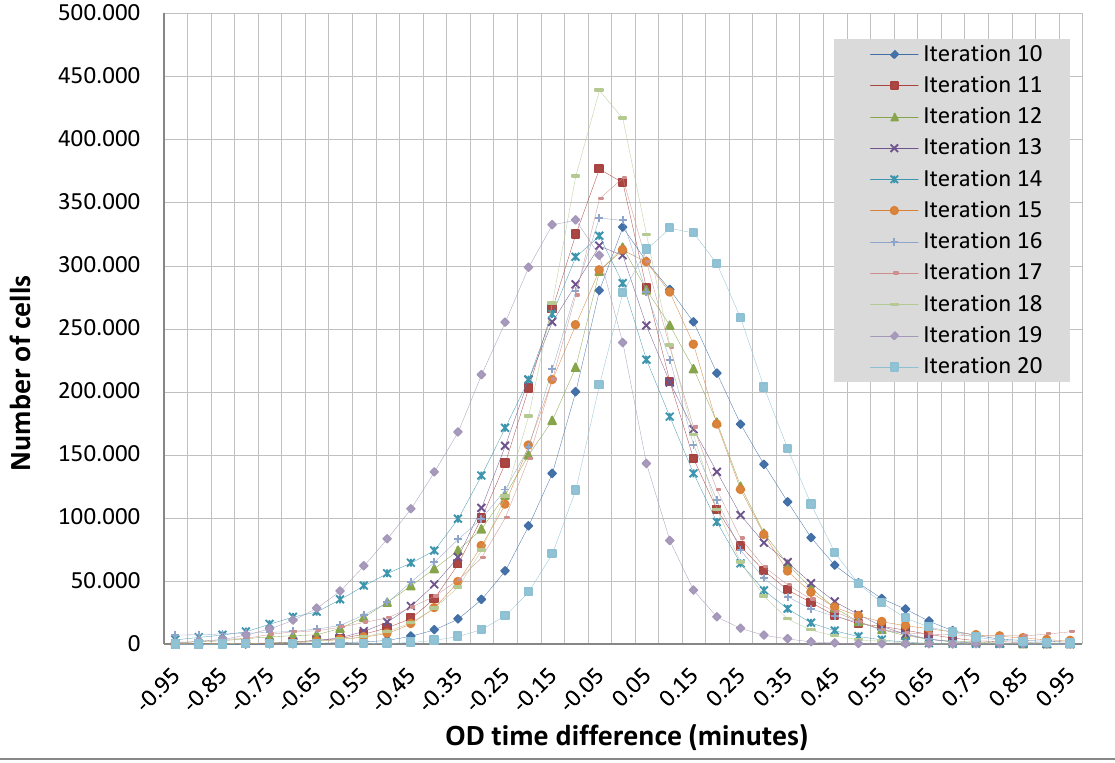
Figure 7. Distribution of OD time differences for various